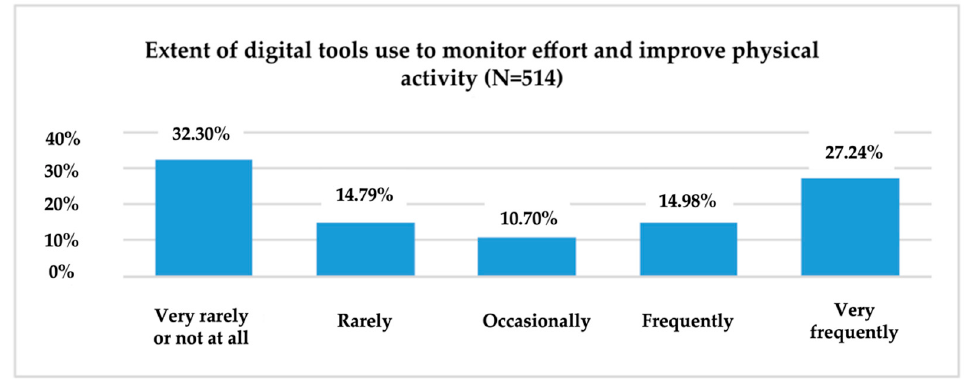
Figure 6. The use of digital tools to monitor and improve physical effort.